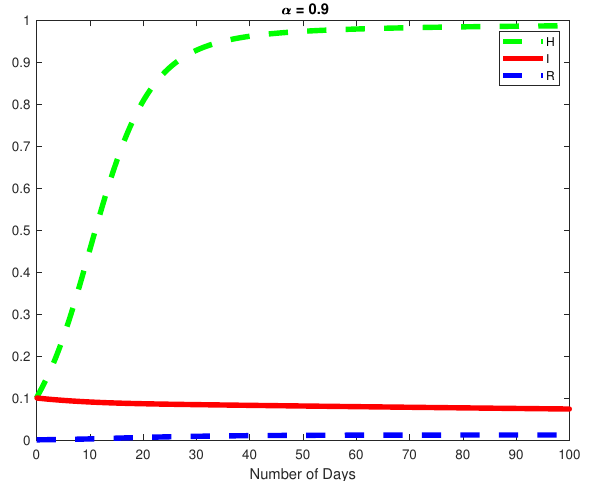
Figure 9. The dynamics of the Healthy ( H ) and Infected ( I ) Hepatocyte and the Immune resonse cytotoxic cells ( R ) for α = 0.7.